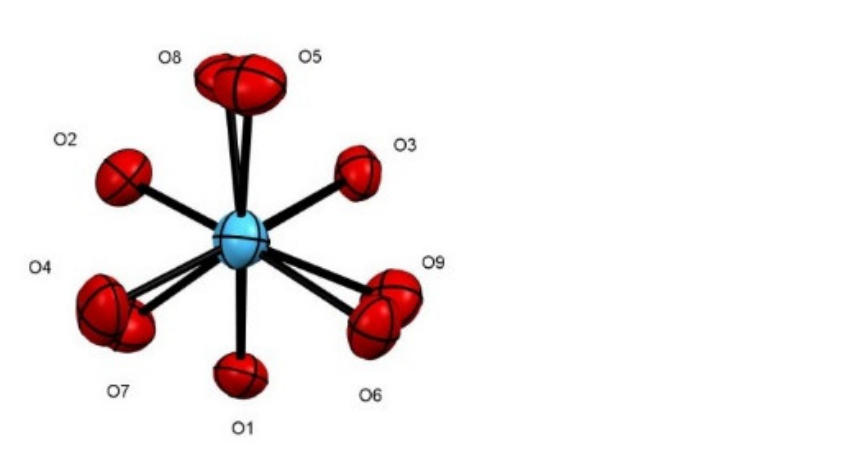
Figure 6. ORTEP drawing of 7 [Hf 2 (OBn) 8 (BnOH)]. Hydrogen atoms are omitted for clarity.